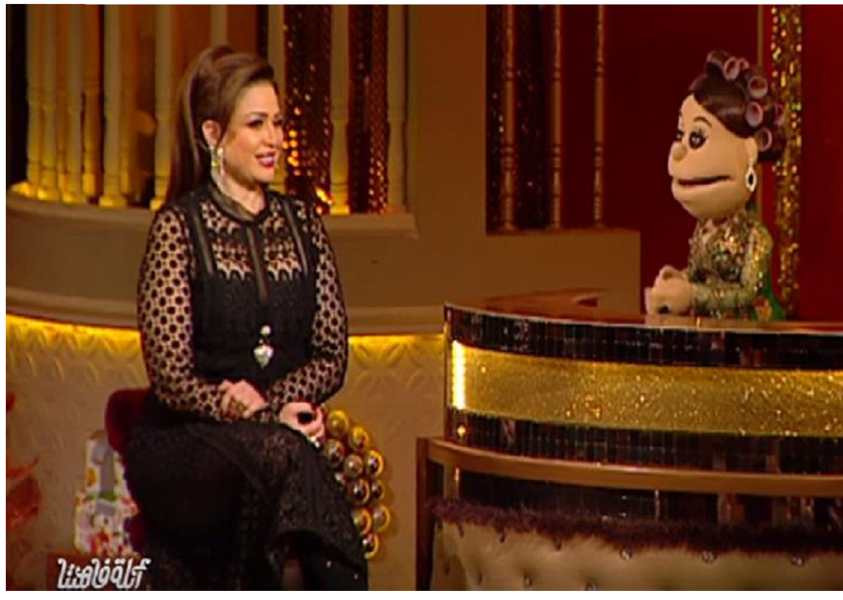
Figure 4: Abla Fahita with Elham Shaheen.